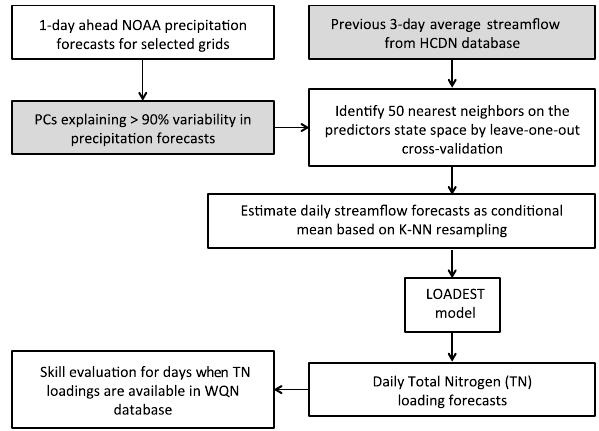
Figure 2. Schematic diagram illustrating the overall approach to forecast daily streamflow and total nitrogen loadings conditioned on the predictors (gray boxes), daily weather forecasts and daily average streamflow values for previous 3 days, based on Kernel- nearest neighbor (K-NN) resampling approach.